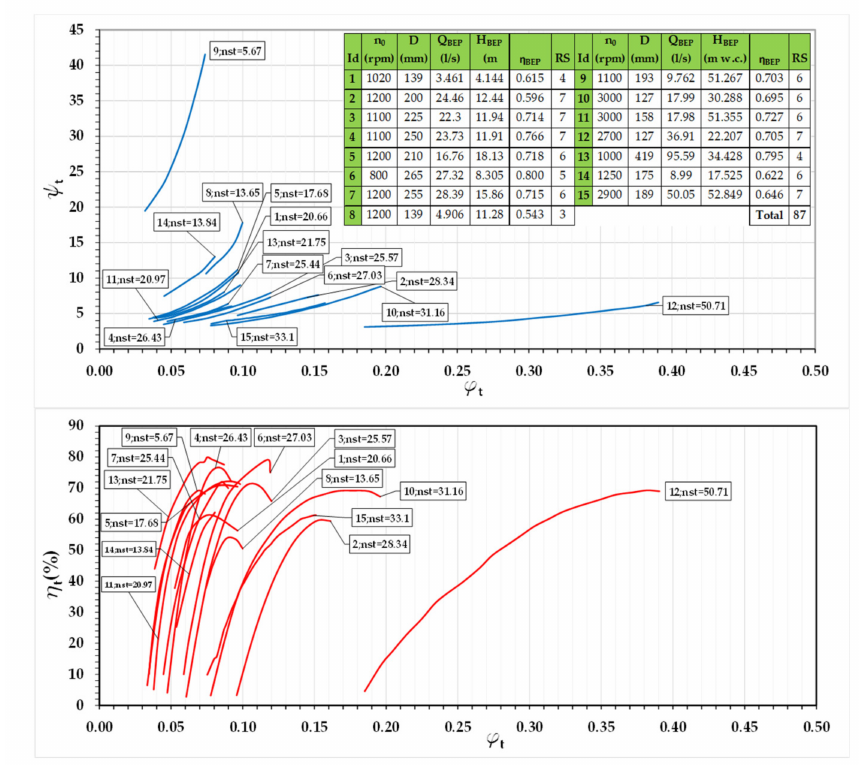
Figure 3. Experimental database. Experimental database. ID1 [23]; ID2-ID4 [24]; ID5-ID7 [21]; ID8 [25]; ID9 [26]; ID10-ID12 [27]; ID13 [28]; ID14 [2]; ID15